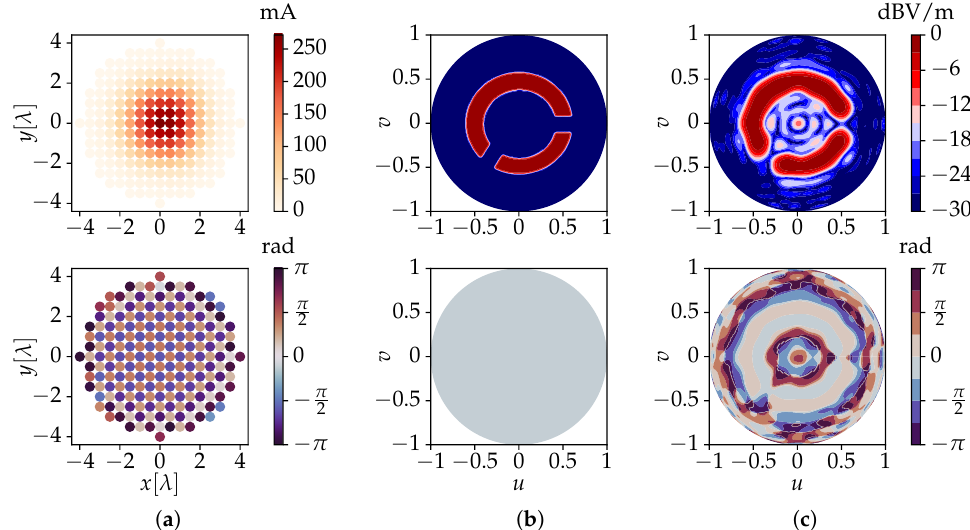
Figure 5. Results for a synthesized planar array consisting of 197 x -polarized dipoles. The figures show the amplitudes ( top ) and phases ( bottom ) of ( a ) the feeding currents obtained by the novel algorithm, for a ( b ) circle-like shaped target near-field and ( c ) the co-polar electric field solution obtained by the novel method. The results in ( b , c ) are drawn for the upper hemisphere of a target sphere of radius R T = 6 λ , where u = sin θ cos φ and v = sin θ sin φ .